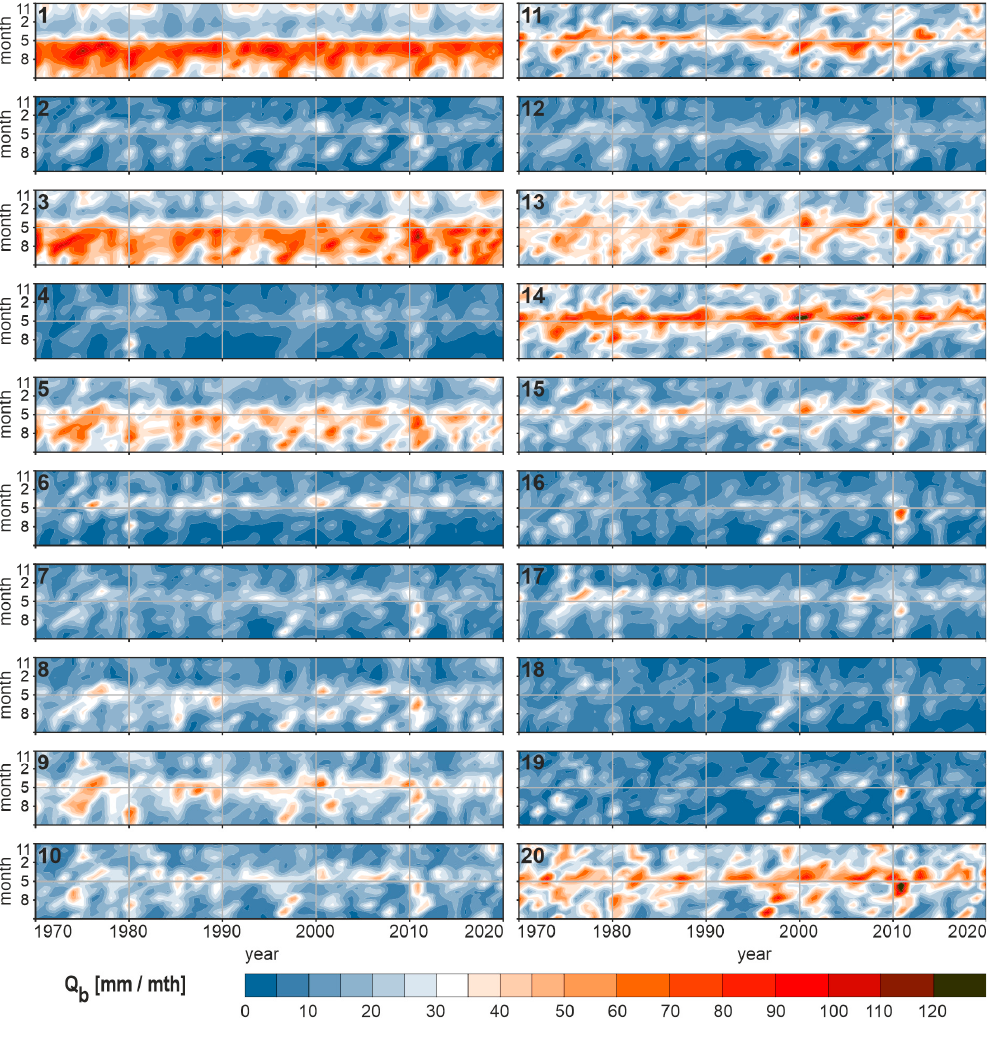
Figure 4. Monthly baseflow totals for the studied catchments in the years 1970–2019. Numbers refer to catchment ID numbers provided in Table 1.